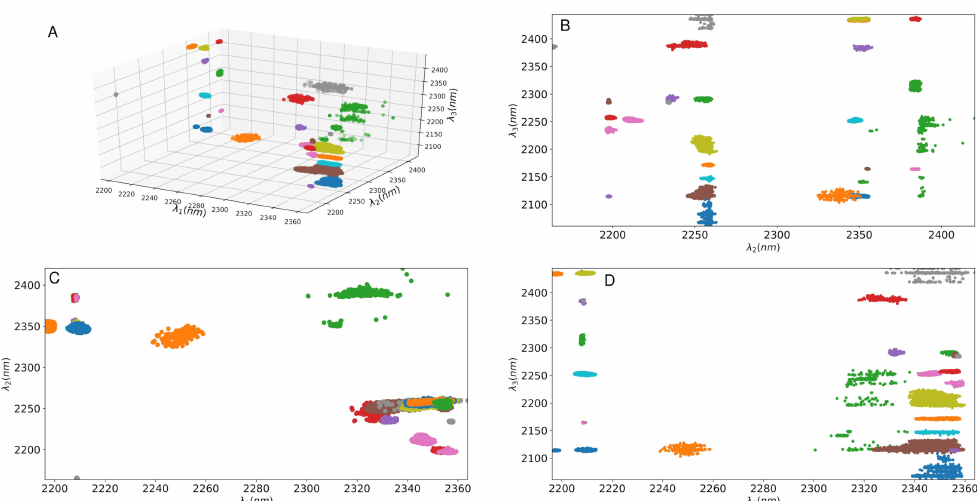
Figure 2. Extracting the deepest, second and third deepest absoprtion features in the 2050–2450 nm spectral region of a spectral dataset and clustering yields the results shown in the ( A ). The different colours in this case are to simply highlight the different clusters and so the reader may see how they are located in the 3D space. Plotting the various feature combinations against each other demonstrates the spectral distribution of the extracted features. ( C ) is the deepest versus second deepest feature wavelengths, ( B ) is the second versus third deepest feature wavelngths and ( D ) is the first versus third